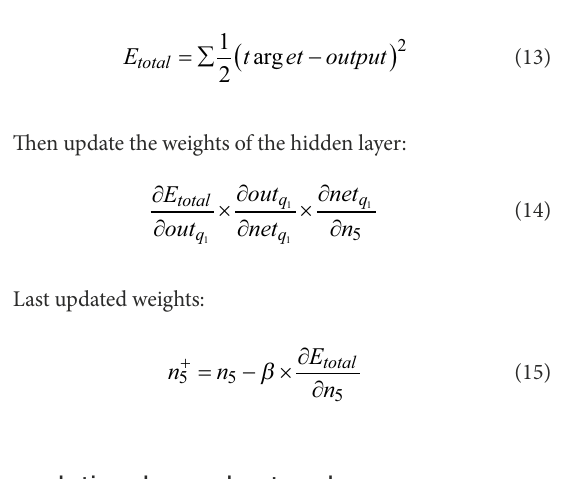
FIGURE 4 Forward neural network model diagram.